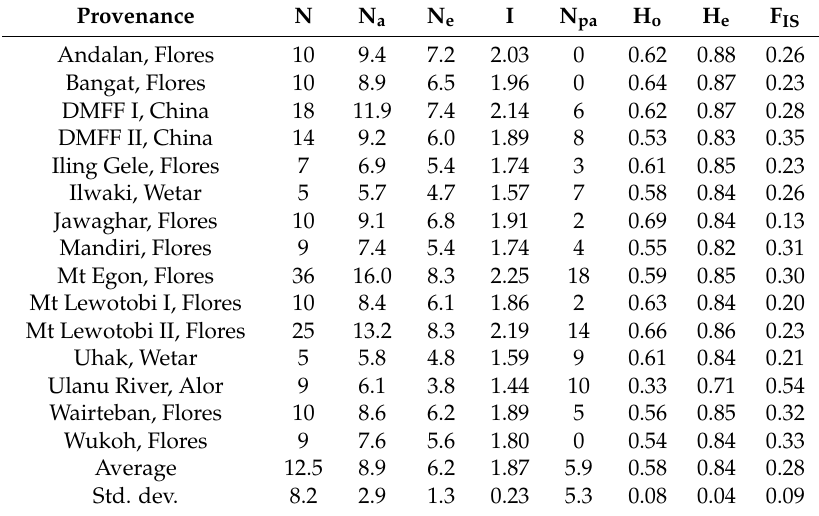
Table 5. Genetic diversity indices for the provenances comprising the first cycle breeding population of E. urophylla —results presented only for the 15 provenances which had 5 or more families sampled.